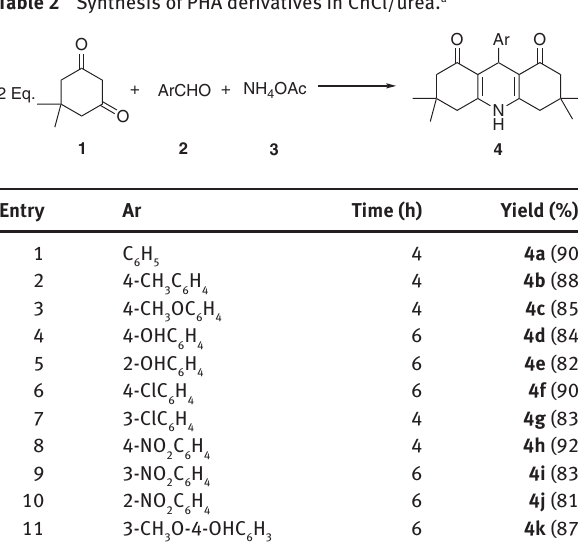
Table 2 Synthesis of PHA derivatives in ChCl/urea.